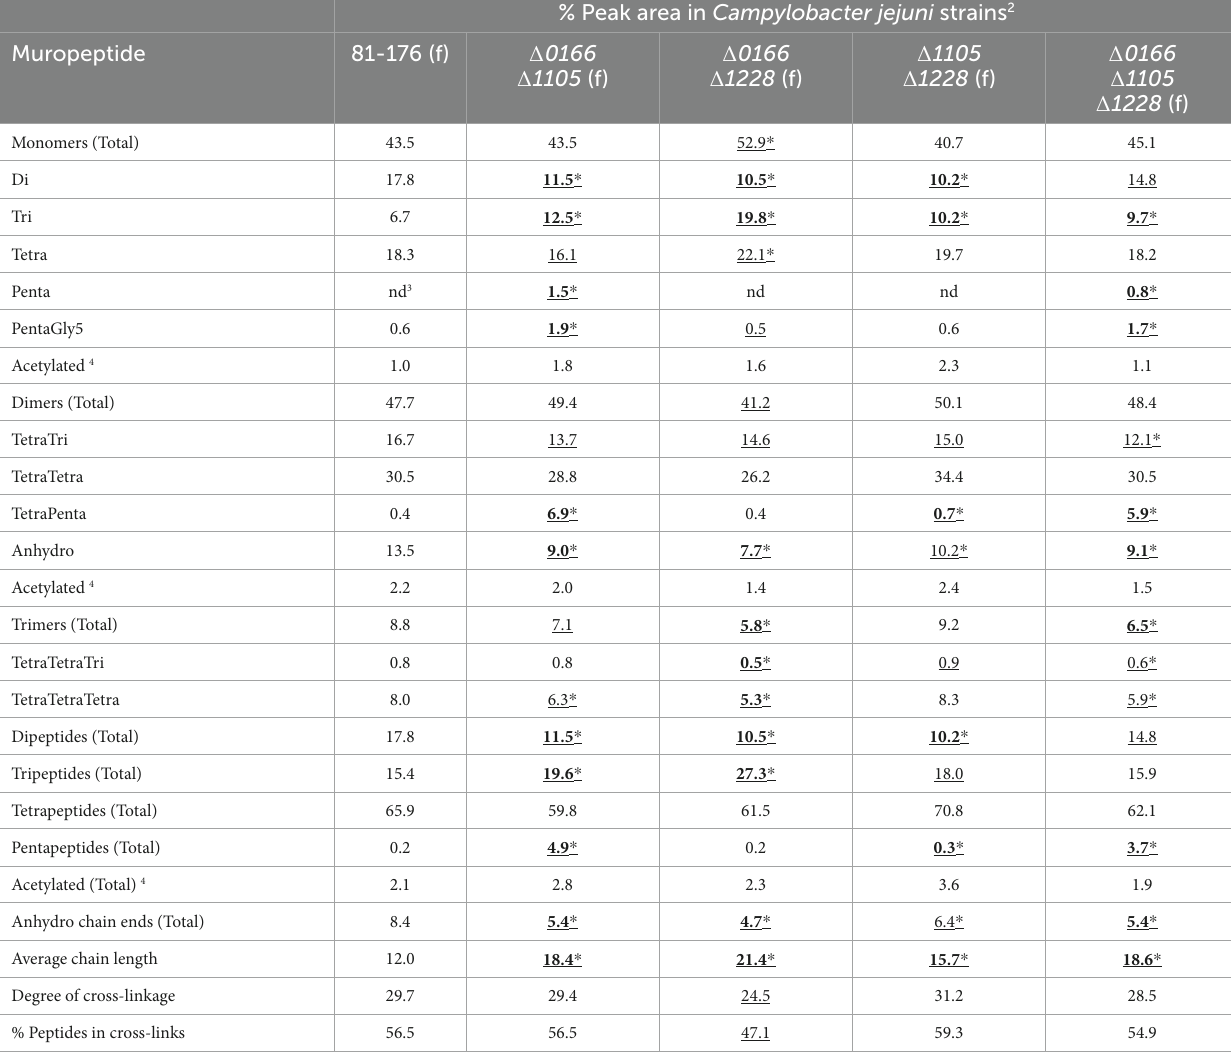
TABLE 3 Summary of the muropeptide composition of 0166 , 1105 , and 1228 double and triple mutants.